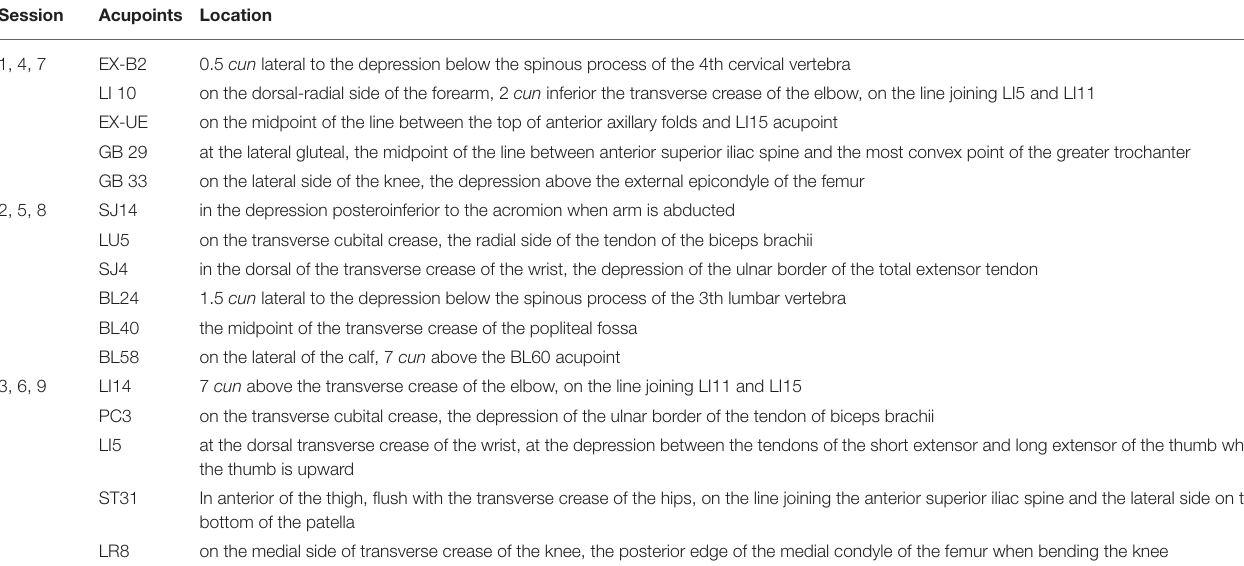
TABLE 1 | Location of acupoints in the treatment group.